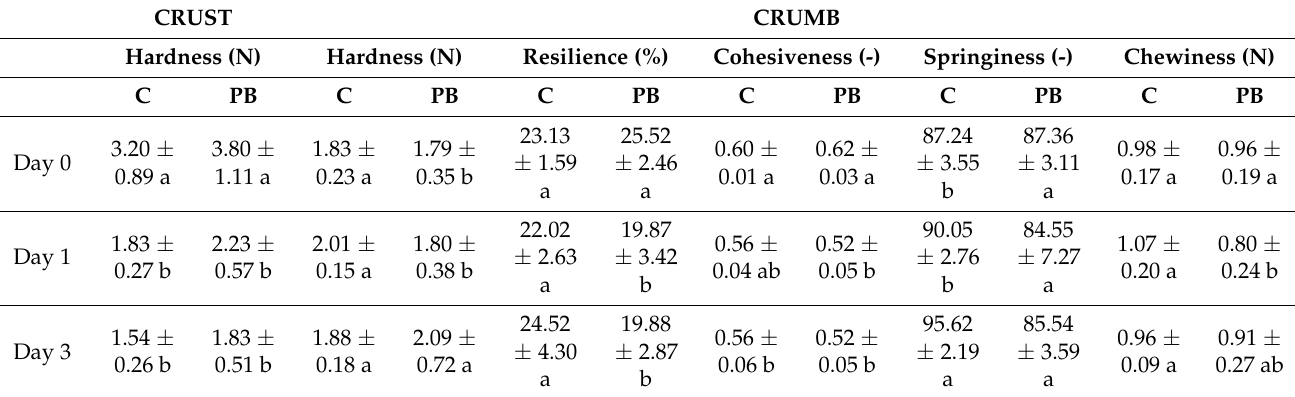
Table 2. Crust and crumb textural parameters during storage for control (C) and parchment bread (PB). CRUST